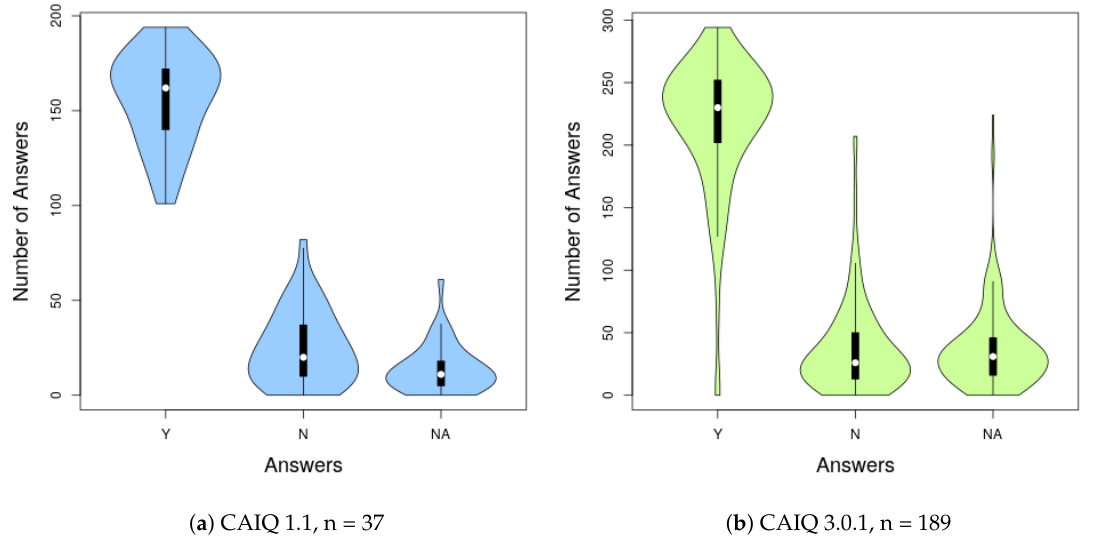
Figure 3. Distribution of Answers per Provider of the CAIQ as